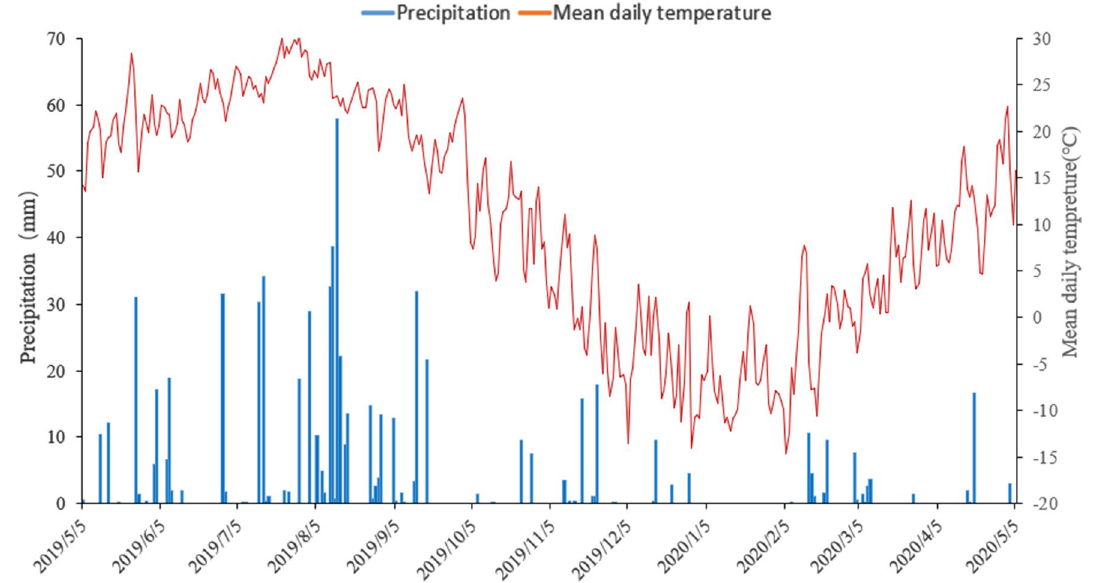
Figure 1. Daily precipitation and mean air temperature during the straw decomposition period from May 2019 to May